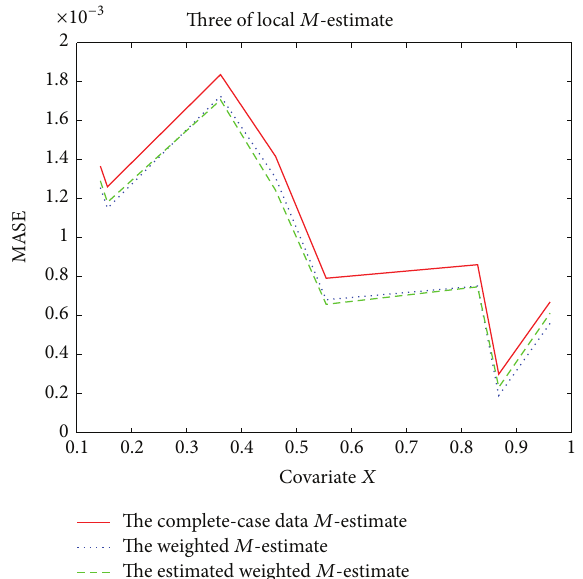
Figure 3: Comparison on the MASE of three 𝑀 -estimators, where the solid curve, the dashed curve, and the dot curve denote the MASE of ̂𝑚 𝑀𝑐𝑐 (𝑥) , ̂𝑚 ∗ 𝑀 (𝑥) , and ̂𝑚 ∗ 𝑀𝑐𝑝 (𝑥) ,